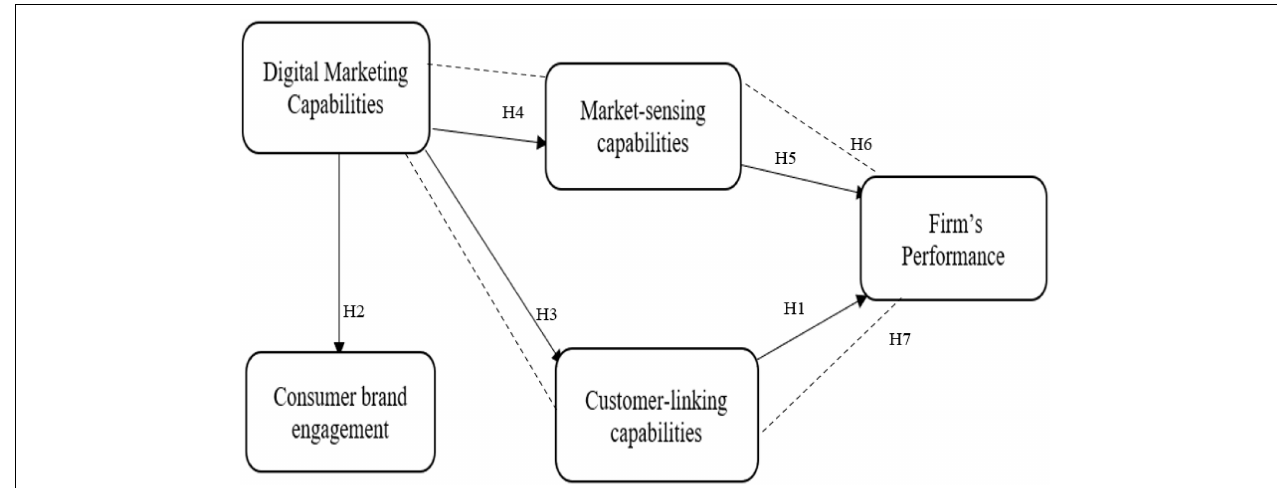
FIGURE 1 | Conceptual